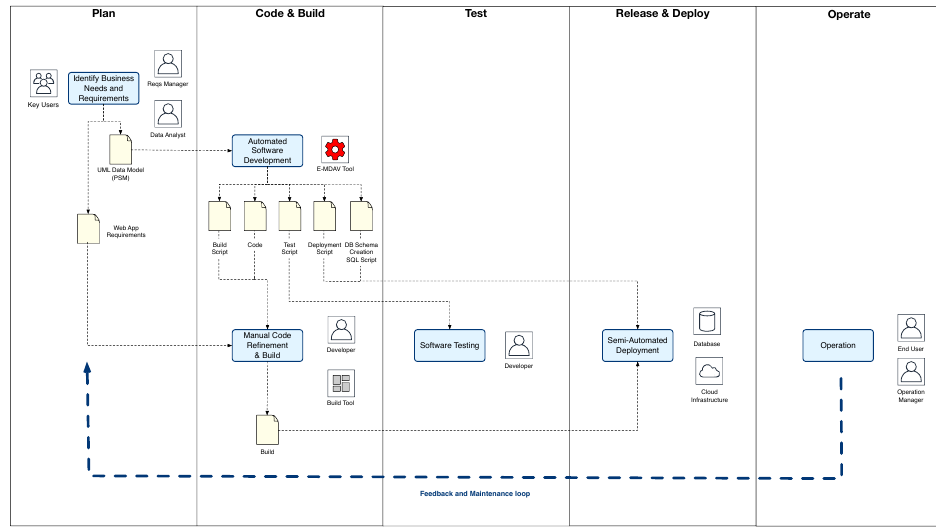
Figure 6. E-MDAV Development